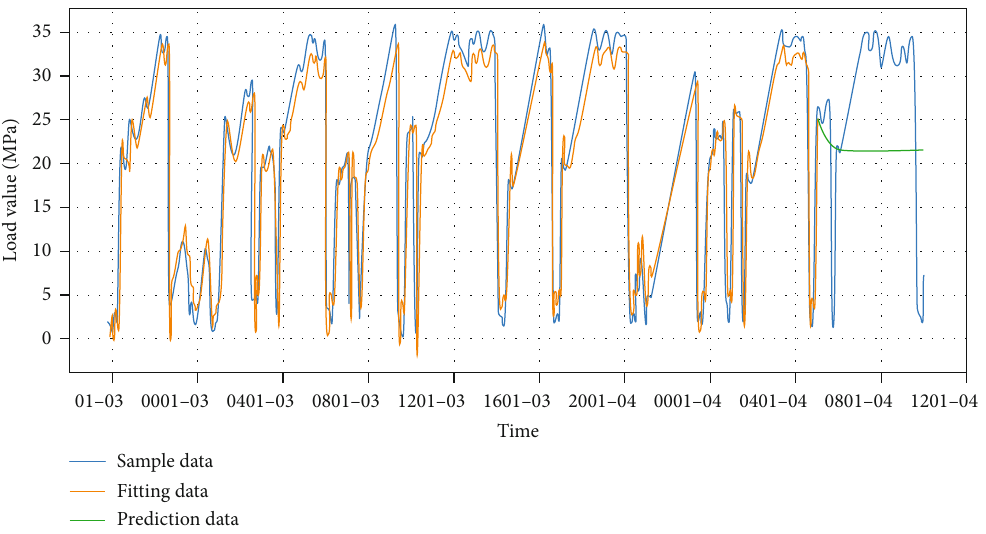
Figure 8: Prediction result for the hydraulic support load.